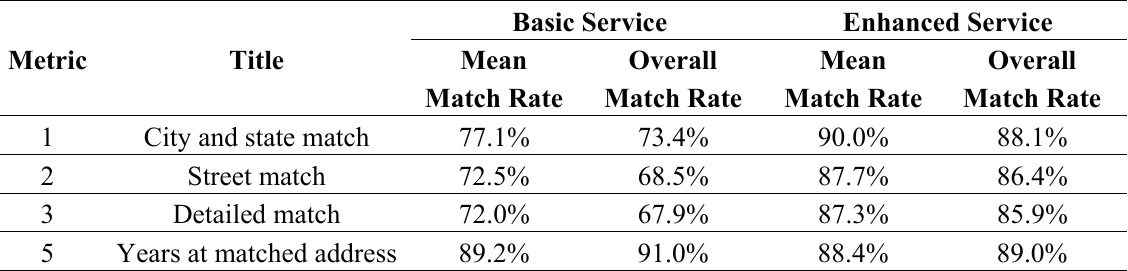
Table 2. Mean subject match rate and overall match rate for Metric 1 of city and state match, Metric 2 of street match, Metric 3 of detailed match, and Metric 5 of years spent at matched address.